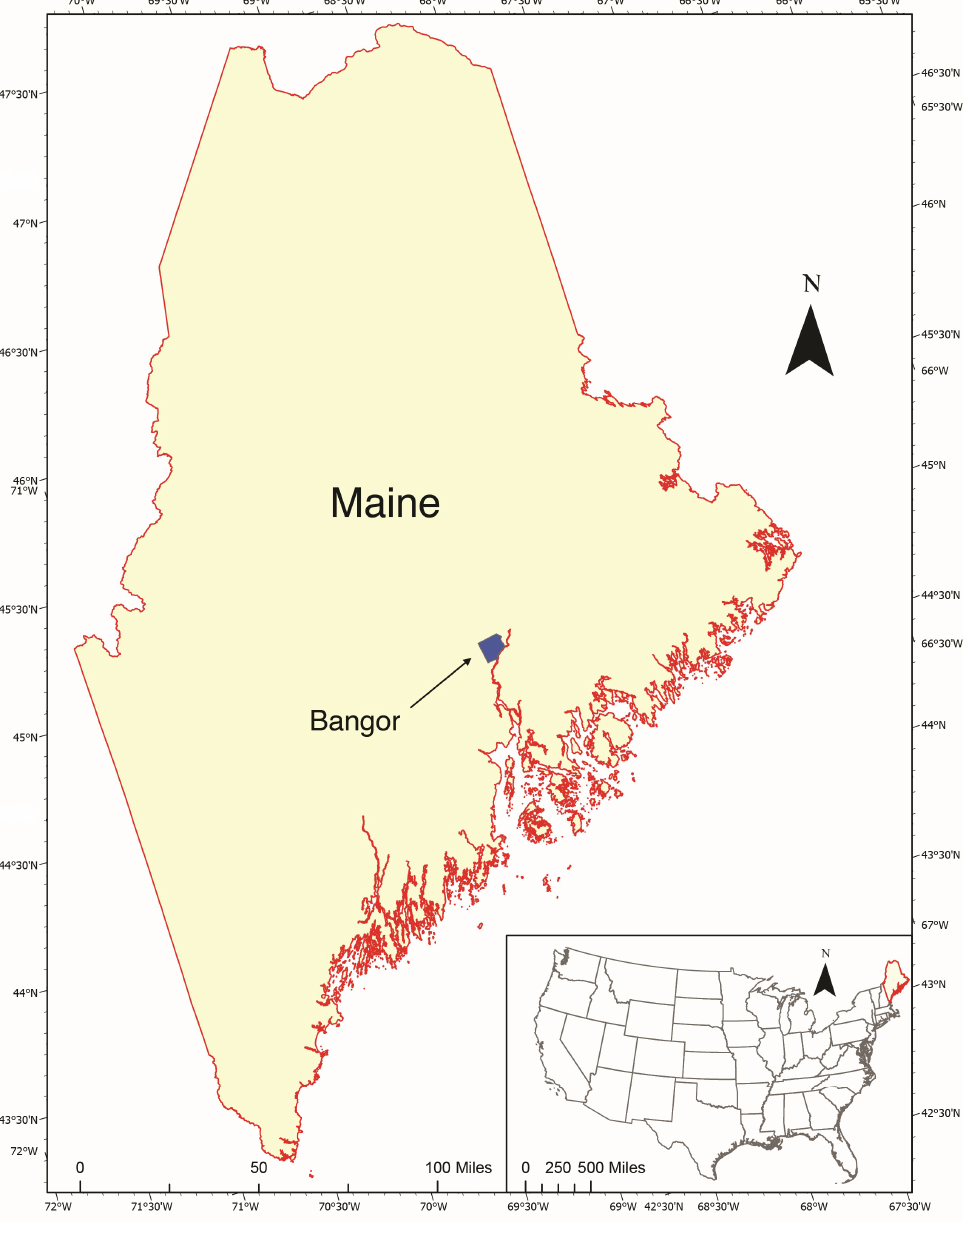
Figure 1. A map showing the location of the study site, Bangor, Maine, USA. Site of Global Historical Climatology Network station USW00014606 is indicated with the blue